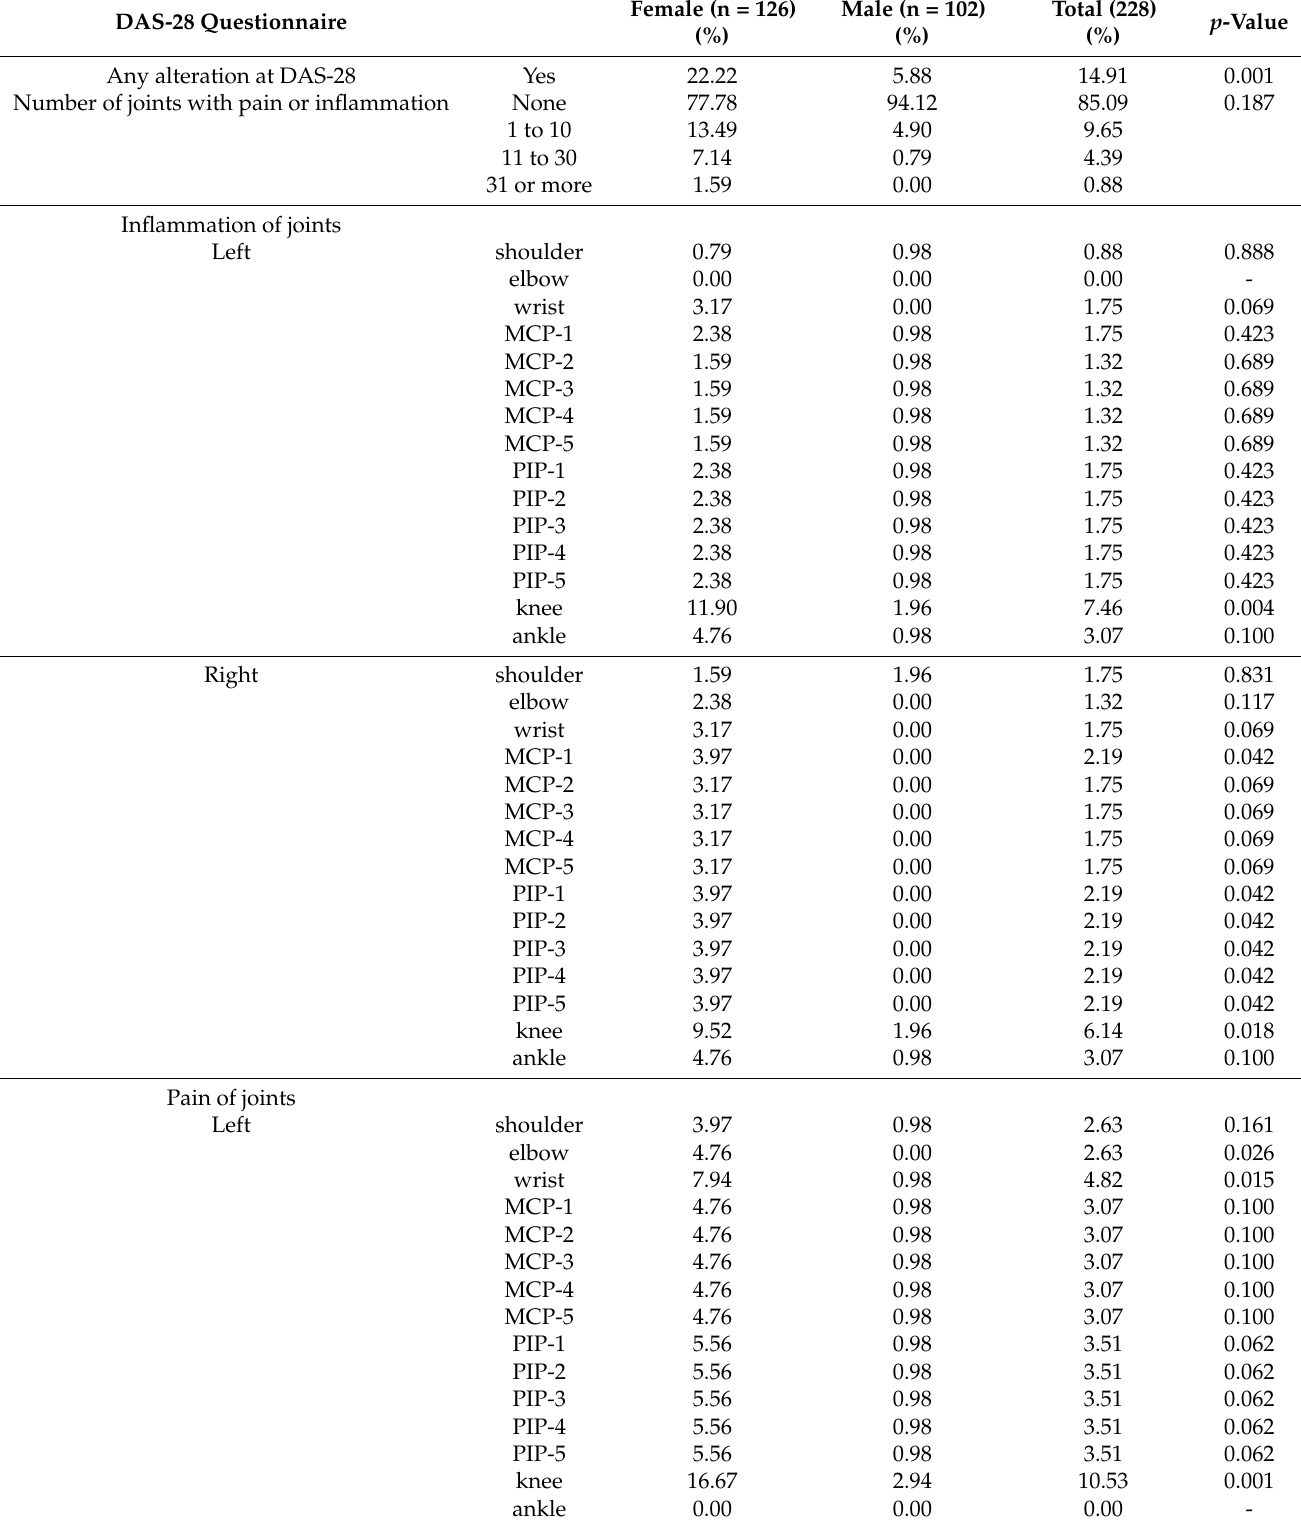
Table 3. DAS-28 findings. Joints with inflammation and pain at follow-up (four